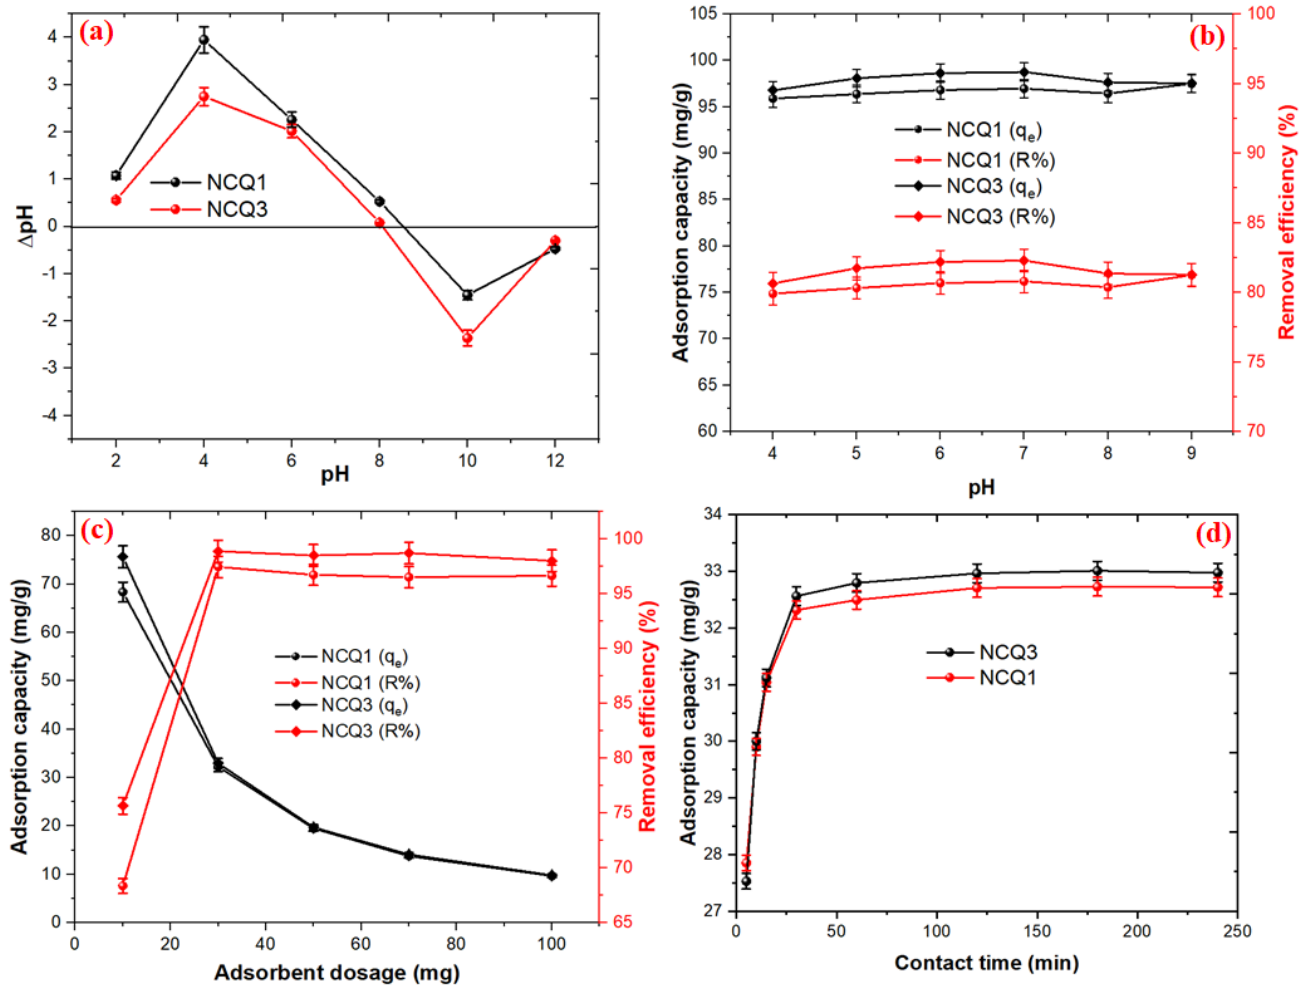
Figure 5 . ( a ) Point of zero charges (pH PZC ). ( b ) Effect of different parameters: pH, ( c ) adsorbent dosage, ( d ) and contact time on adsorption CV dye onto both NCQ1 and NCQ3 adsorbents.